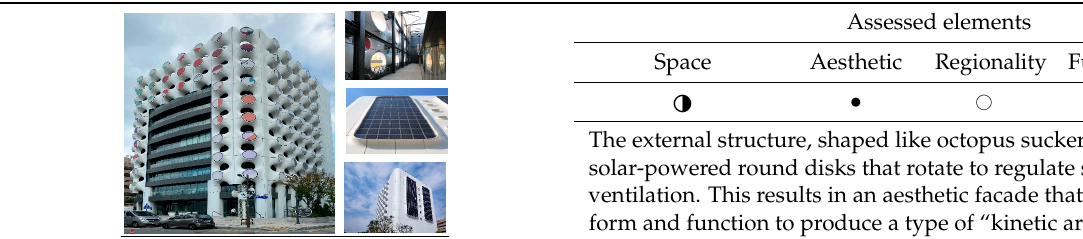
Table 8. Adaptive facades: PLACE1 (THE_SYSTEM LAB 2017).